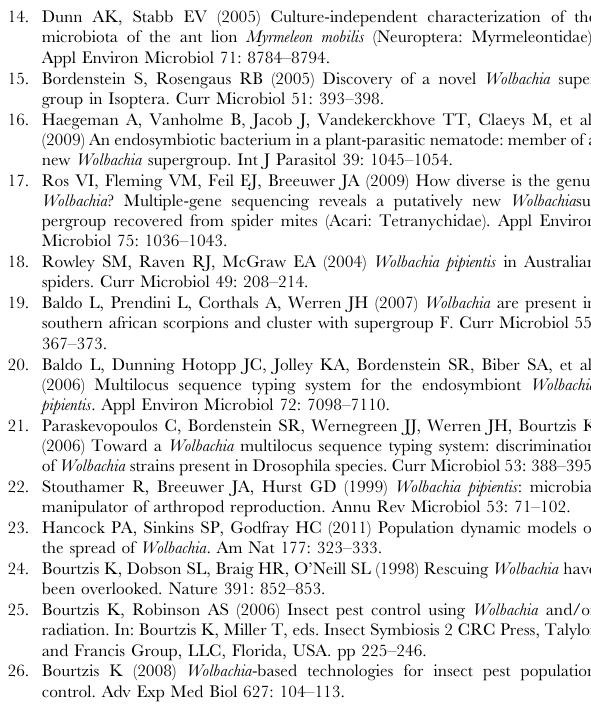
Figure S1 Position of the primers used in this study, relative to the 16S rRNA gene from wMel. Figure S2 Bayesian inference phylogeny based on gltA data. The three new Wolbachia strains are indicated with bold letters, and the other strains represent supergroups A, B, C, D, F, H, I, and K. Strains are designated with the names of their host species, followed by the collection site and the sample name. Bayesian posterior probabilities (top numbers) and ML bootstrap values based on 100 replicates (bottom numbers) are given. Figure S3 Bayesian inference phylogeny based on gatB data. The 10 new Wolbachia strains are indicated with bold letters, and the other strains represent supergroups A, B, D, F, and H. Strains are designated with the names of their host species, followed by the collection site and the sample name. Bayesian posterior probabilities (top numbers) and ML bootstrap values based on 100 replicates (bottom numbers) are given. Figure S4 Bayesian inference phylogeny based on fbpA data. The four new Wolbachia strains are indicated with bold letters, and the other strains represent supergroups A, B, D, and F. Strains are designated with the names of their host species, followed by the collection site and the sample name. Bayesian